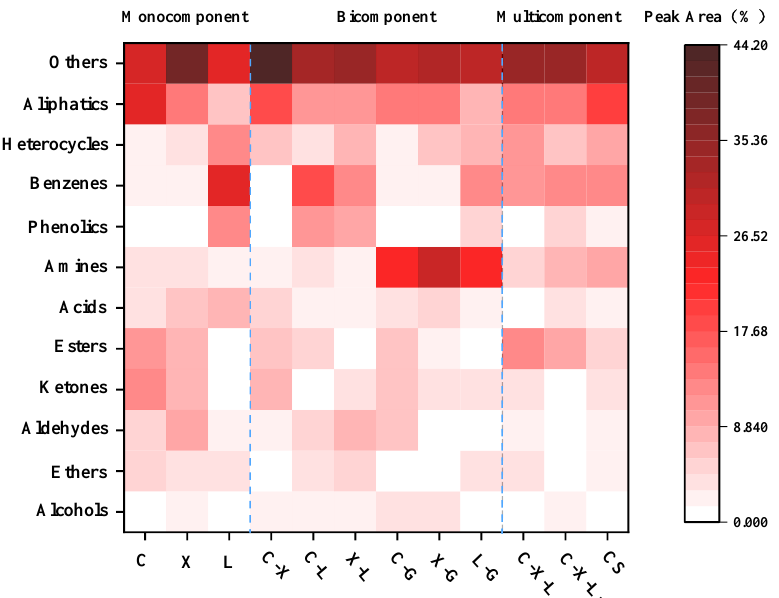
Figure 4. Hydro-thermal bio-oil compounds are distributed in different mono-component, binary blends, and multi-variate blends. Combing the TG and GC-MS results for different ratios of model components (cellu- lose, xylan, lignin, and glycine). Their interaction during low-temperature hydro-thermal conversion is summarized in Figure 5.